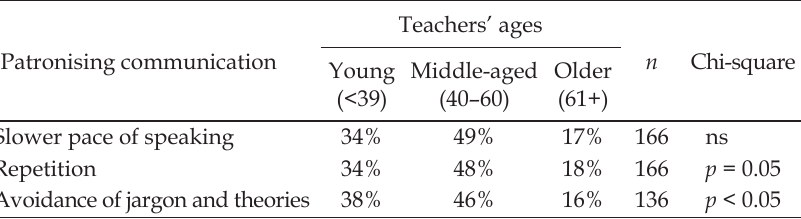
Table 2 . Use of patronising communication styles, by teachers’